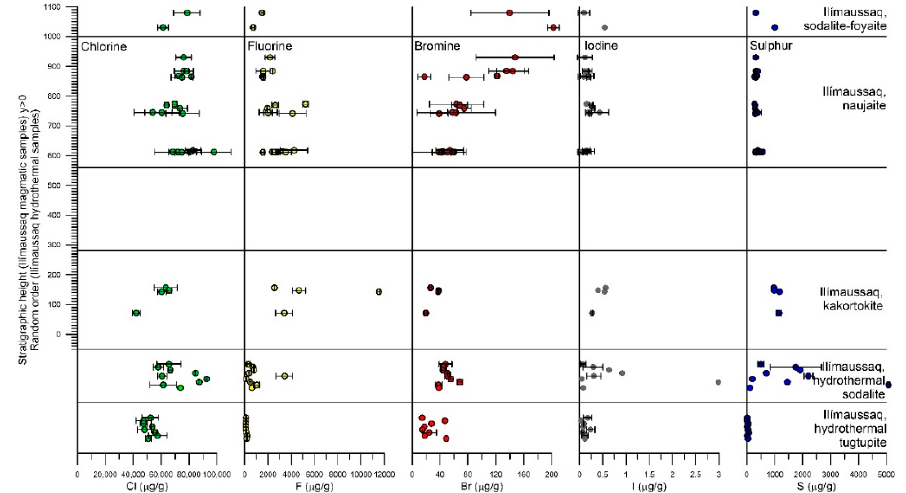
Figure 4. Halogen (Cl, F, Br, and I) and S concentrations in sodalite and tugtupite based on CIC measurements. Magmatic Ilímaussaq samples are sorted according to their stratigraphic height in the intrusion, other samples are randomly ordered within each group.